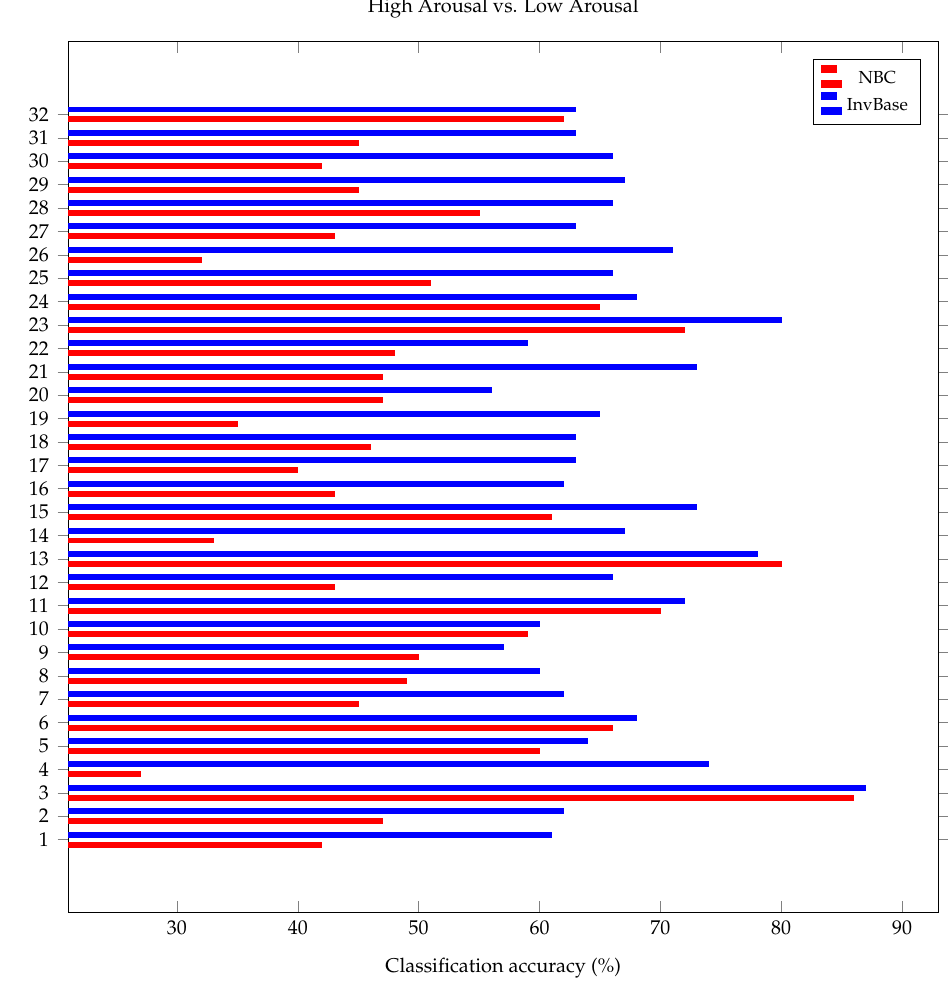
Figure 12. Comparison of arousal classification accuracy using InvBase method and NBC in leave one out cross